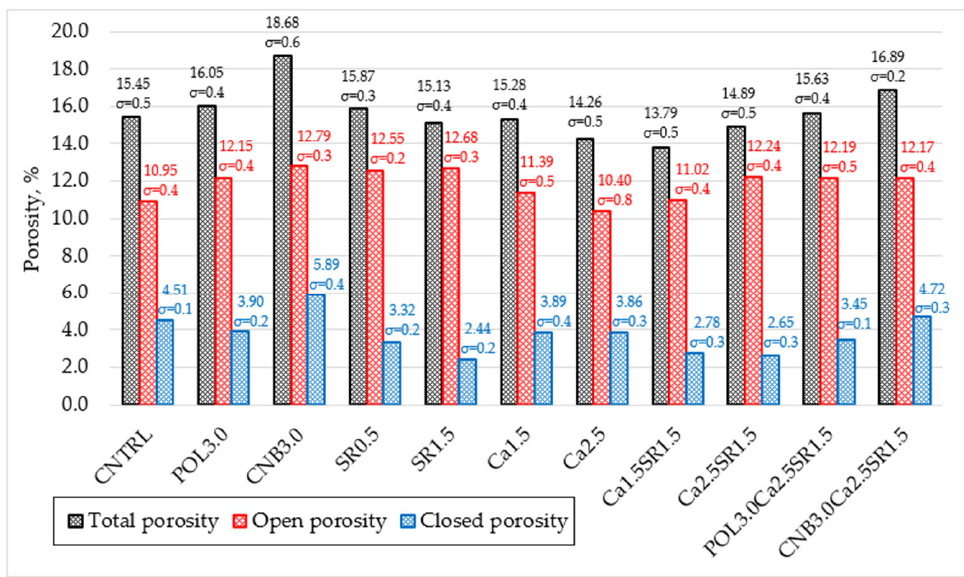
Figure 14. Total, open, and closed porosity of concrete.